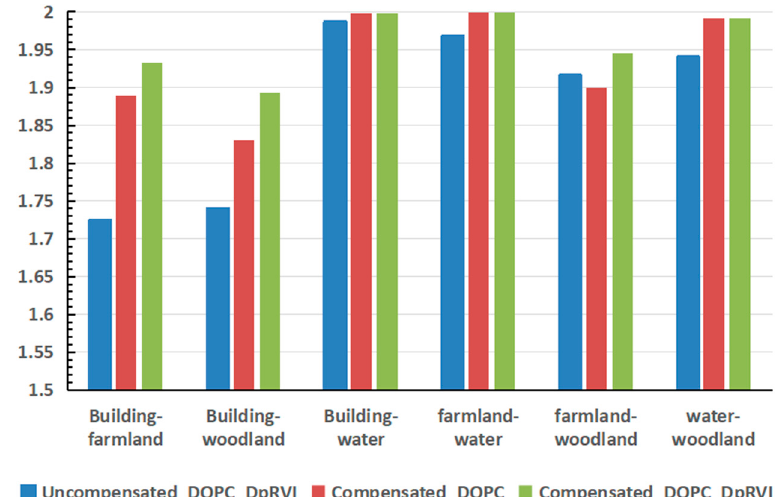
Figure 13. J-M distance based on di ff erent scenic feature combinations.